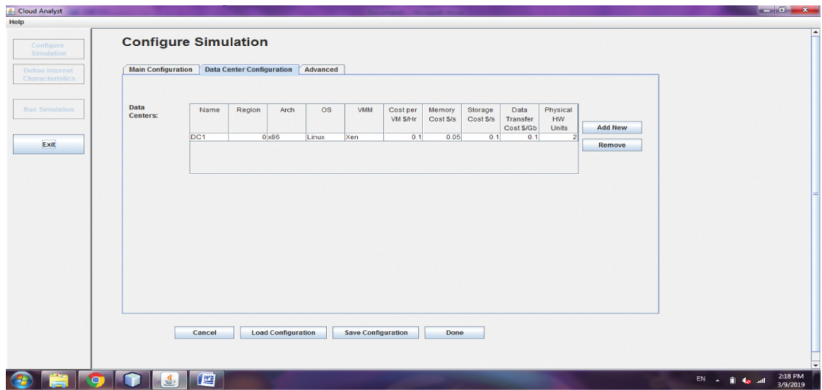
Figure 5: New Data Center Creation Window.